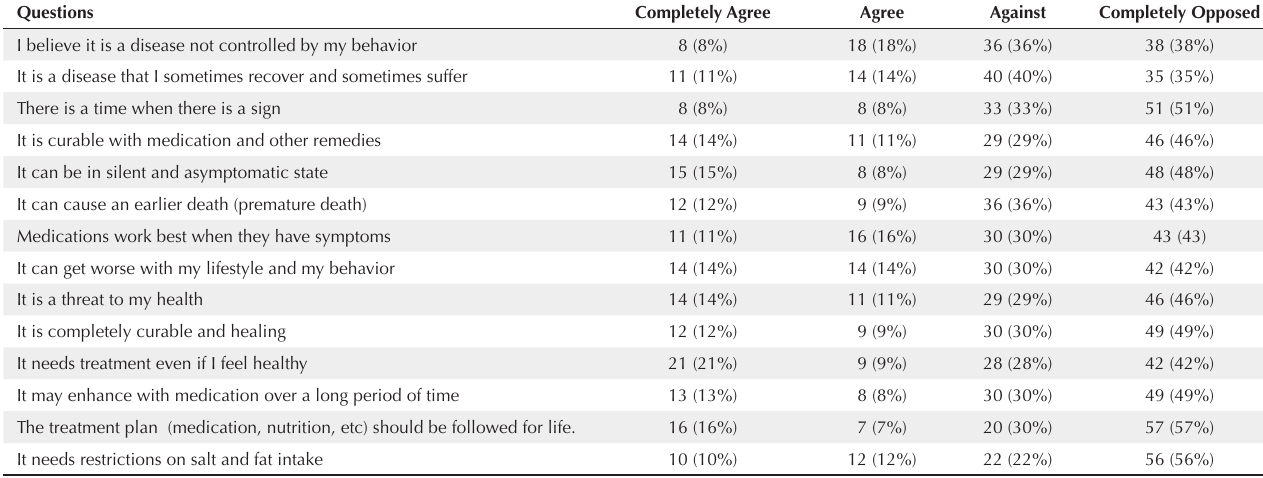
Table 2. Questions and Percentage of Responses relevant to Understanding Patients with Hypertension Questions